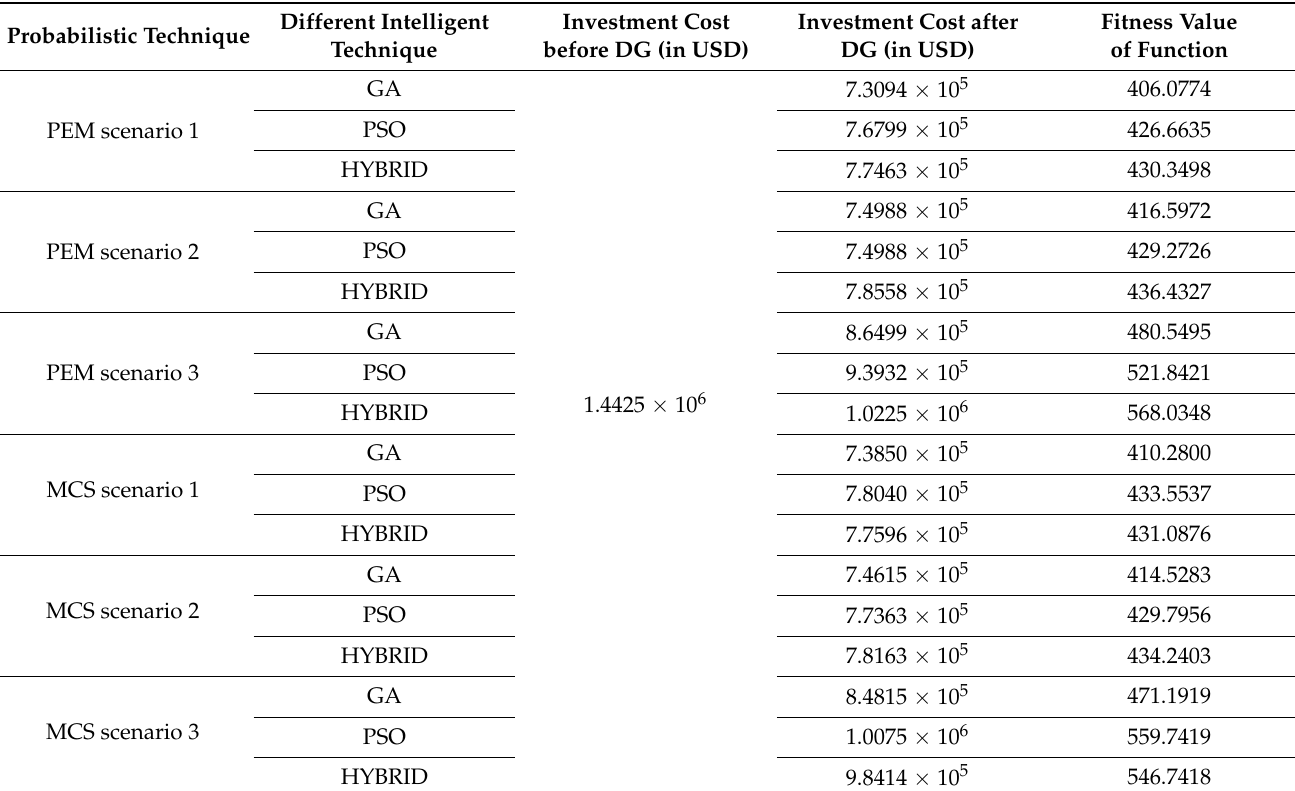
Table 7. Comparison of different parameters using PEM and MCS based method for uncertainty for different scenarios of various optimization